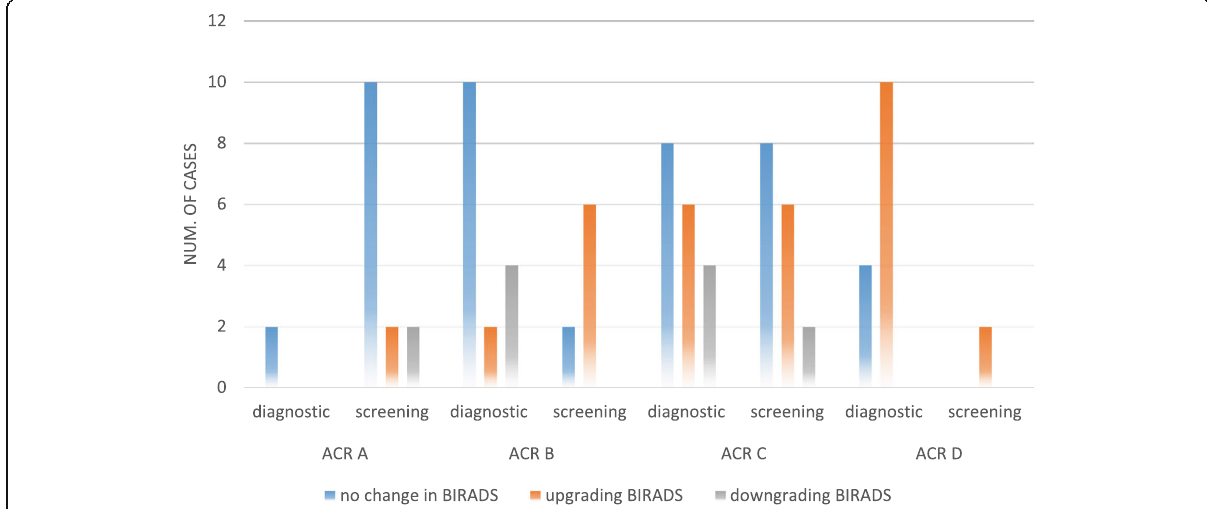
Fig. 7 Effect of addition of DBT to FFDM on BIRADS scoring in different breast densities in diagnostic and screening setup